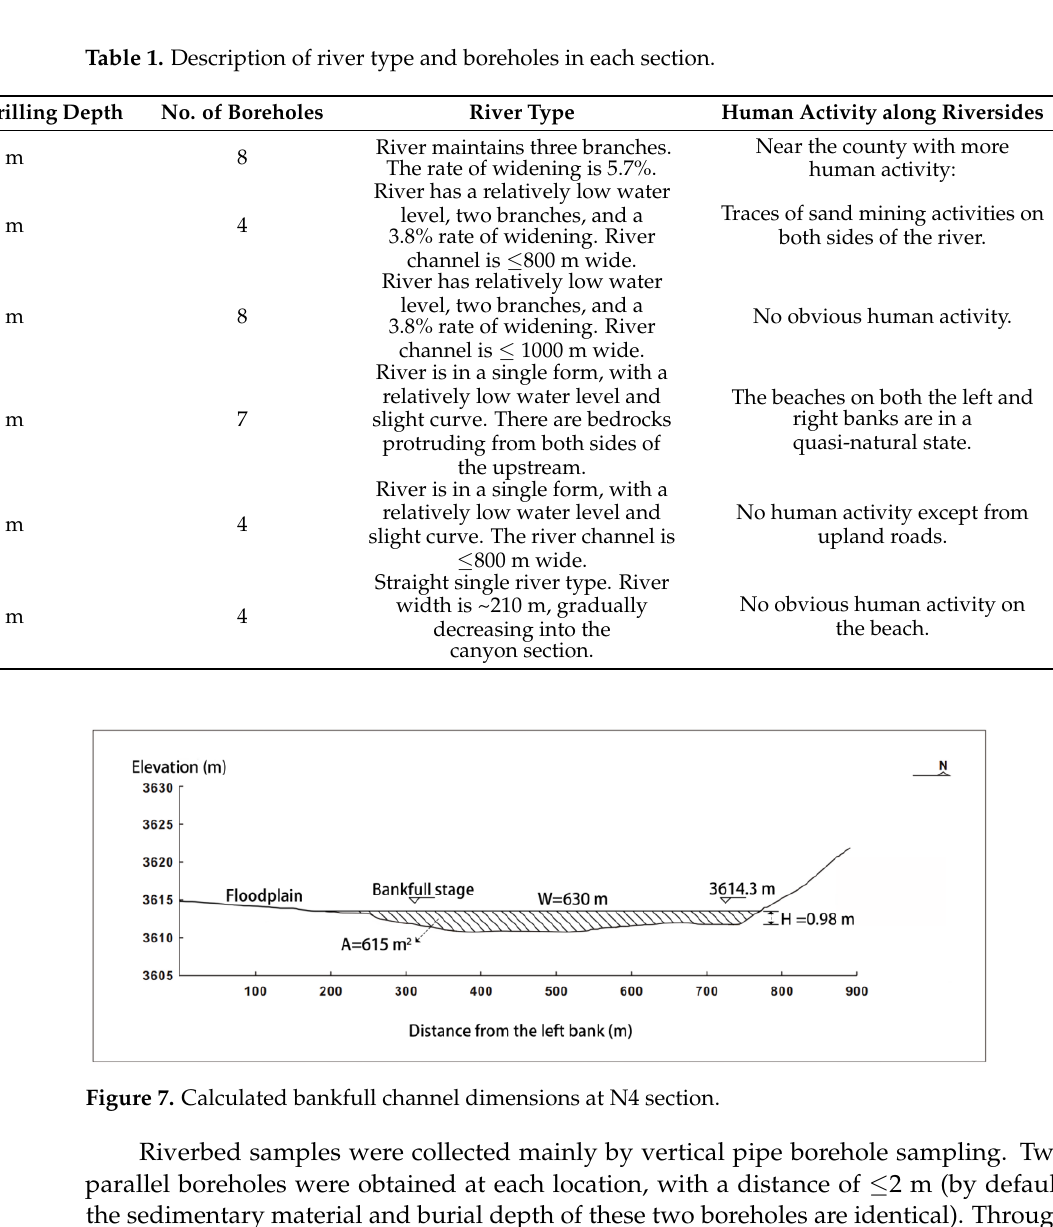
Table 2. Characterization of riverbed sediments at N4 profile of the Nangqian section along the Zhaqu River.